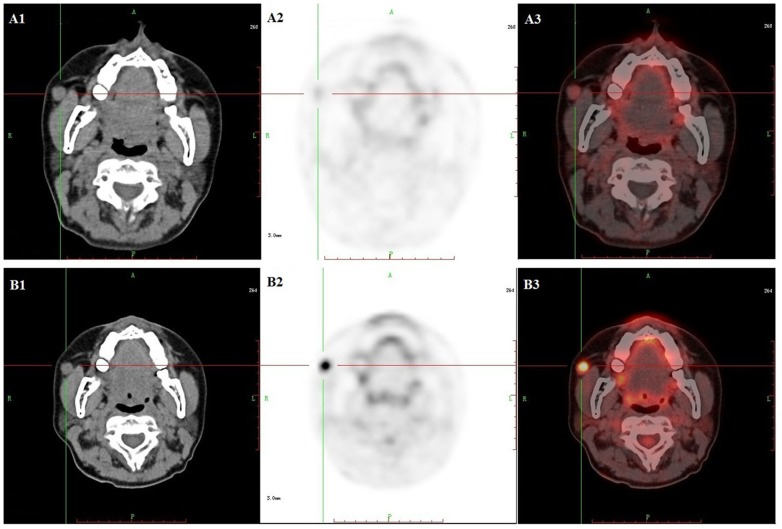
Comparison of different uptake patterns in 18F-AIF-NOTA-PRGD2 PET and 18F-FDG PET.The enlarged lymph node identified on CT (A1 and B1) had significantly higher uptake of 18F-FDG PET (B2–B3) than that for 18F-AIF-NOTA-PRGD2 (A2–A3).